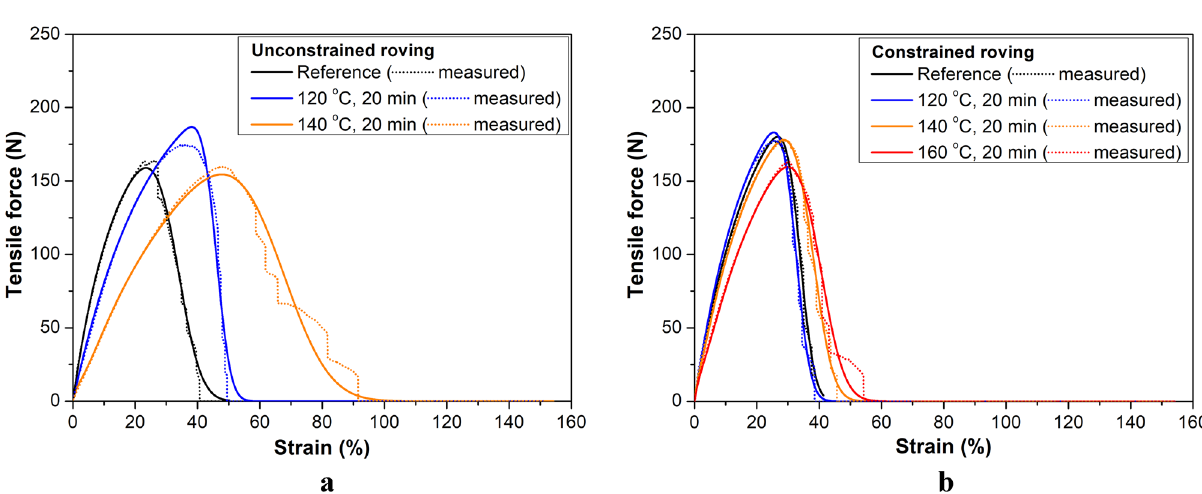
Figure 12. Measured and fitted E-bundle force–strain curves of rovings unconstrained ( a ) and constrained ( b ). Heat treatment was performed at different temperatures for 20